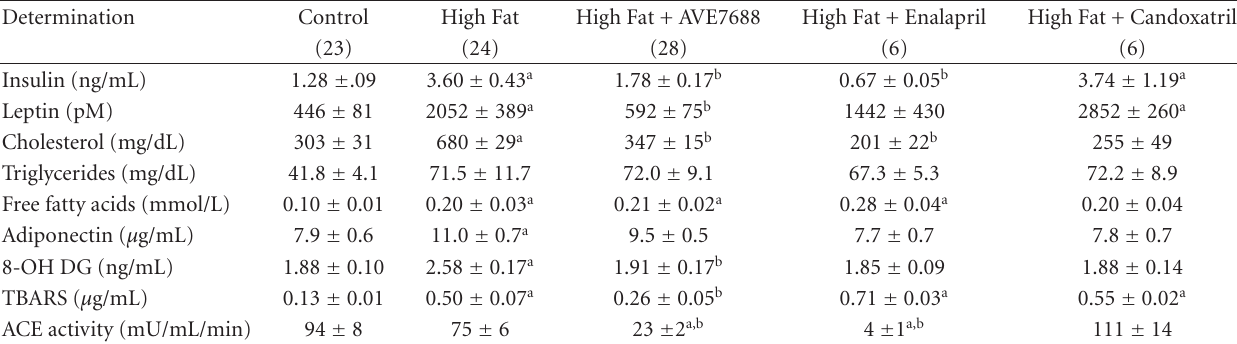
Table 2: E ff ect of high fat diet ± AVE7688, Enalapril or Candoxatril on change in serum insulin, leptin, cholesterol, triglycerides, free fatty acids, adiponectin, 8-hydroxy deoxyguanosine, TBARS, and ACE activity. Determination